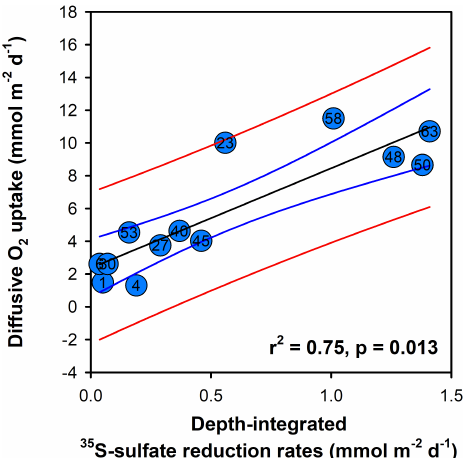
Figure 7. Cross plot of diffusive oxygen uptake and integrated sul- fate reduction rates. The black line is the result of the regression analysis that yielded a y intercept of 2.1mmolm − 2 d − 1 and a slope of 6.1 ± 0.1. Blue and red lines show the 95 and 99% confidence